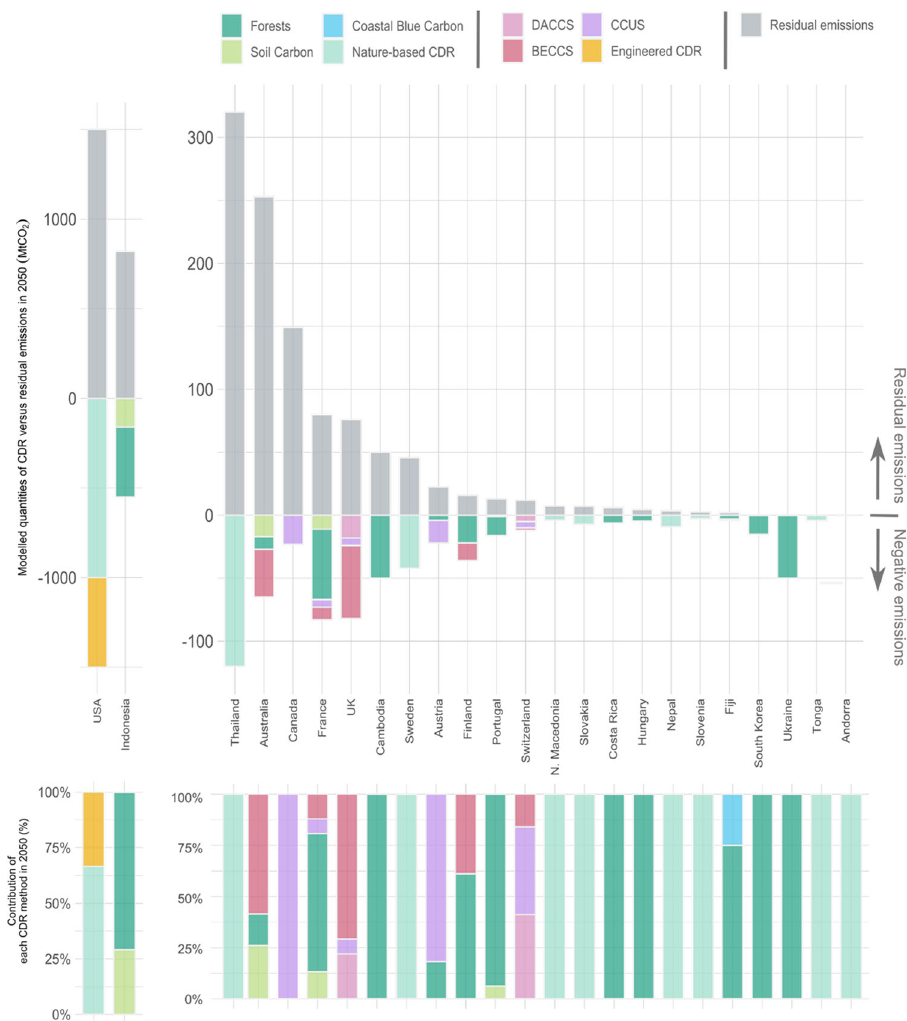
energy with carbon capture and storage. ‘ DACCS ’ refers to direct air carbon capture and storage. ‘ CCUS ’ refers to carbon capture utilisation and/or storage. The top panel details residual emissions (positive values) and negative emissions achieved by CDR (negative values), adapted from the strategies themselves. Larger CDR values than residual emissions indicate a country where negative emissions through CDR is modelled to exceed residual